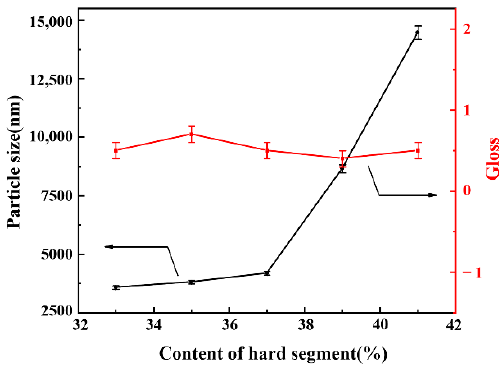
Figure 8. The particle sizes of WPU-H dispersions and gloss of WPU-H films with different hard segment contents.